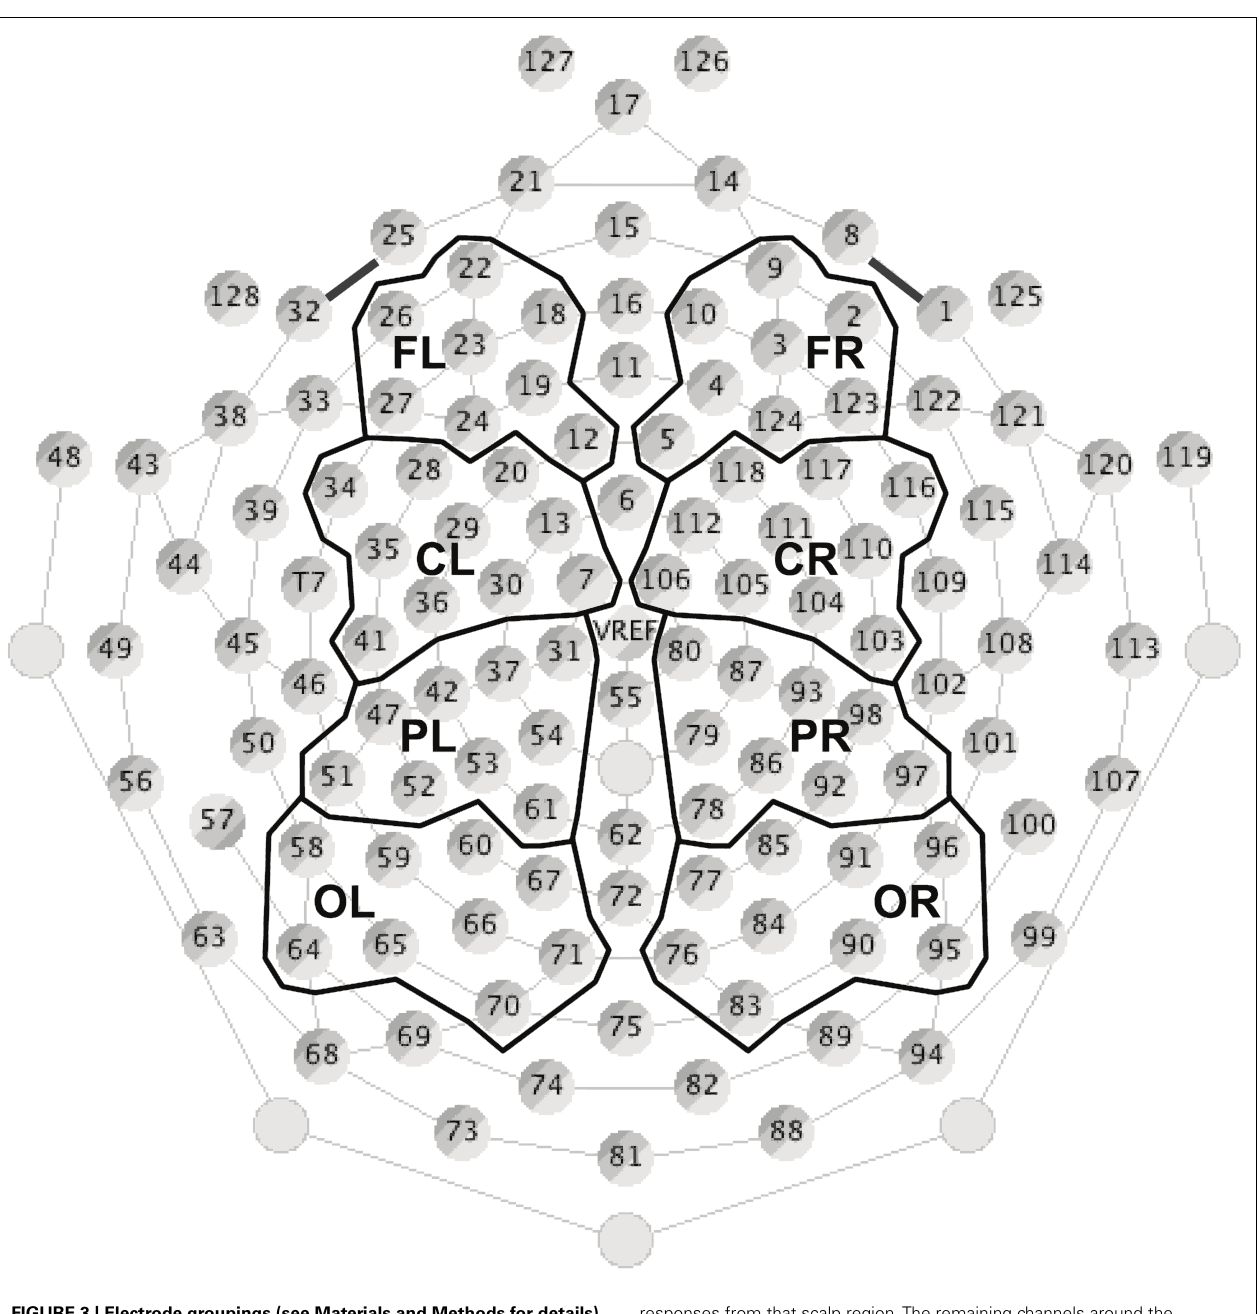
FIGURE 3 | Electrode groupings (see Materials and Methods for details). Seventy-two of 128 electrodes were divided into four groups (frontal, central, parietal, and occipital) for each hemisphere. Each group contained between 16 and 20 electrodes that were averaged together to represent EEG